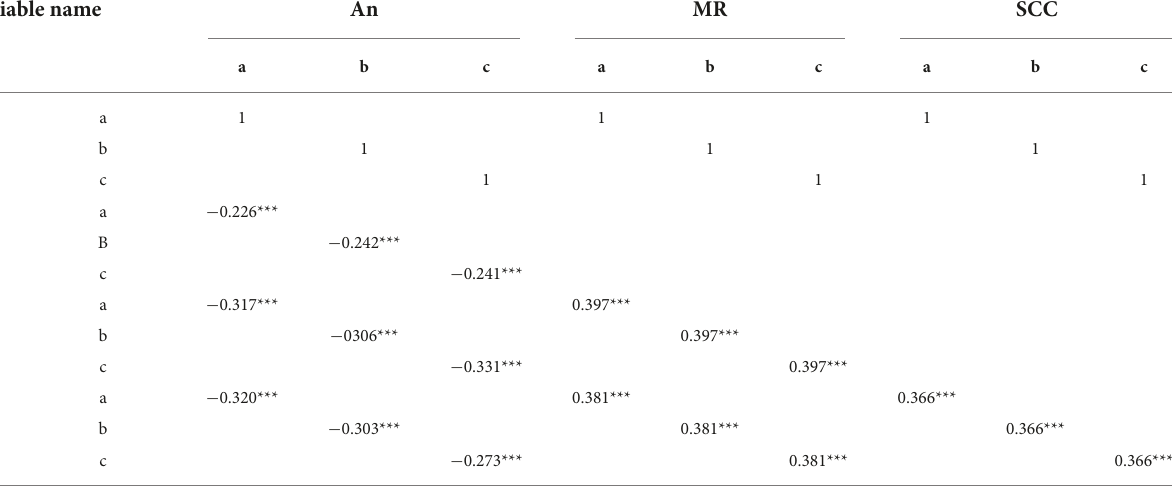
self-concept clarity–life satisfaction, mother alienation was negatively correlated with mental resilience ( r = −